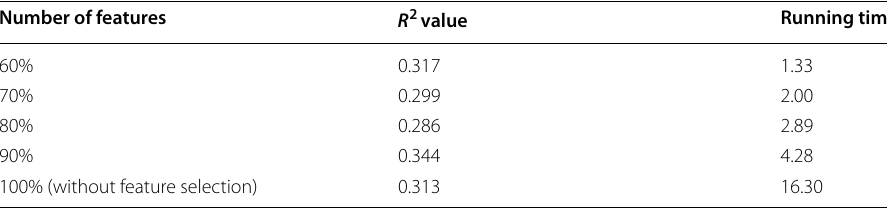
Table 2 QSAR-RFR(PCA) simulation results on ECFP_4 dataset Number of features